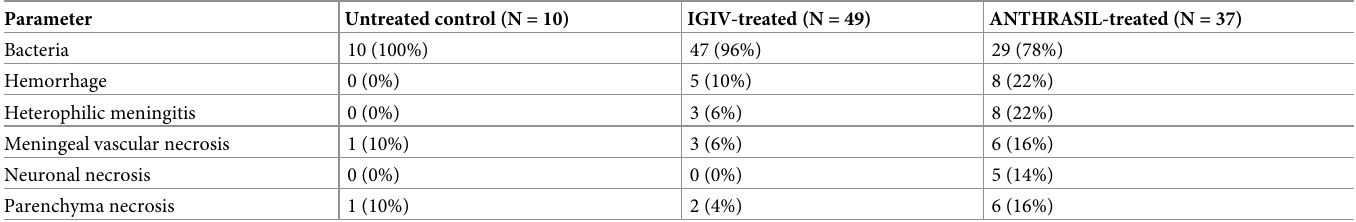
Table 5. Incidence of brain lesions in IGIV or ANTHRASIL-treated rabbits that died on the study.